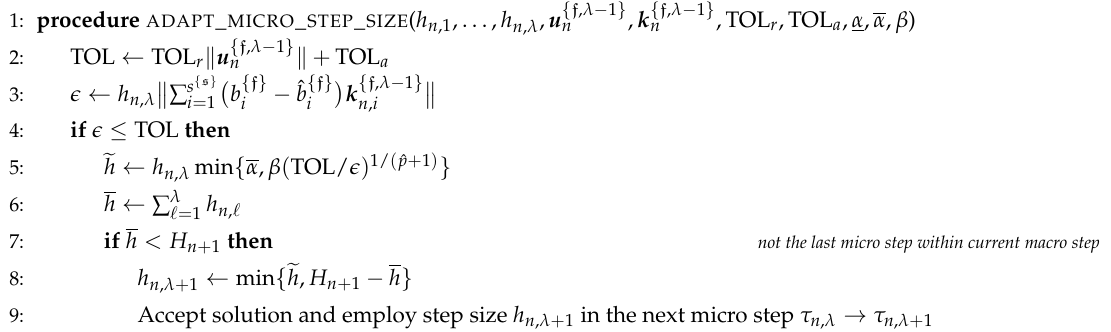
1 → τ n , λ with step size h n , λ −